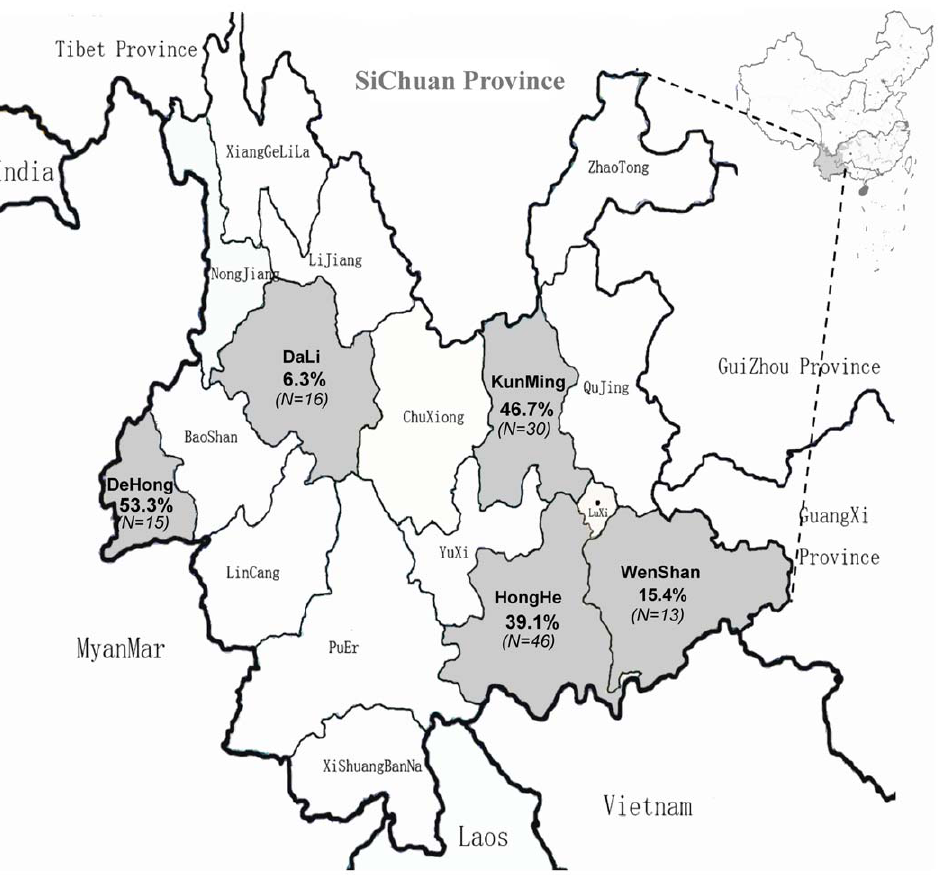
Figure 1. Map of the Yunnan Province in the People’s Republic of China. Gray areas mark the five prefectures the 120 IDUs were recruited. GBV-C positive rates were shown in percentages.